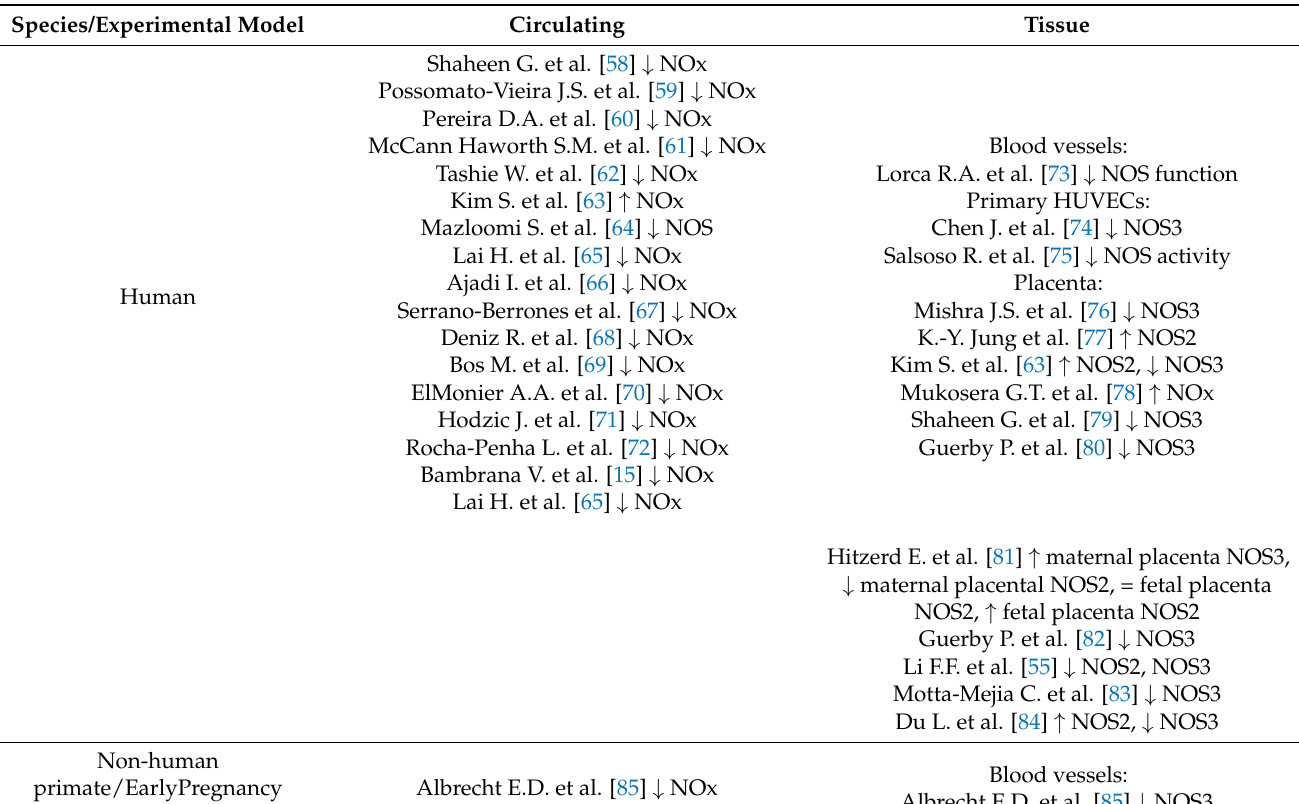
Table 1. PubMed search results for keywords “nitric oxide” AND “preeclampsia” form 2015-pr. Arrows represent the direction of change ( ↑ , increased; ↓ , decreased), and equal signs (=) represent no change in NOS expression/NO biomarkers (NOx). Species/Experimental